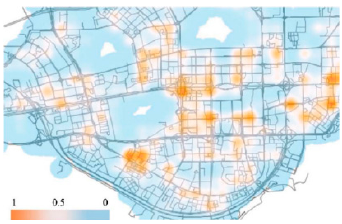
Figure 15. Hotspot detection with the heatmap technique [47].